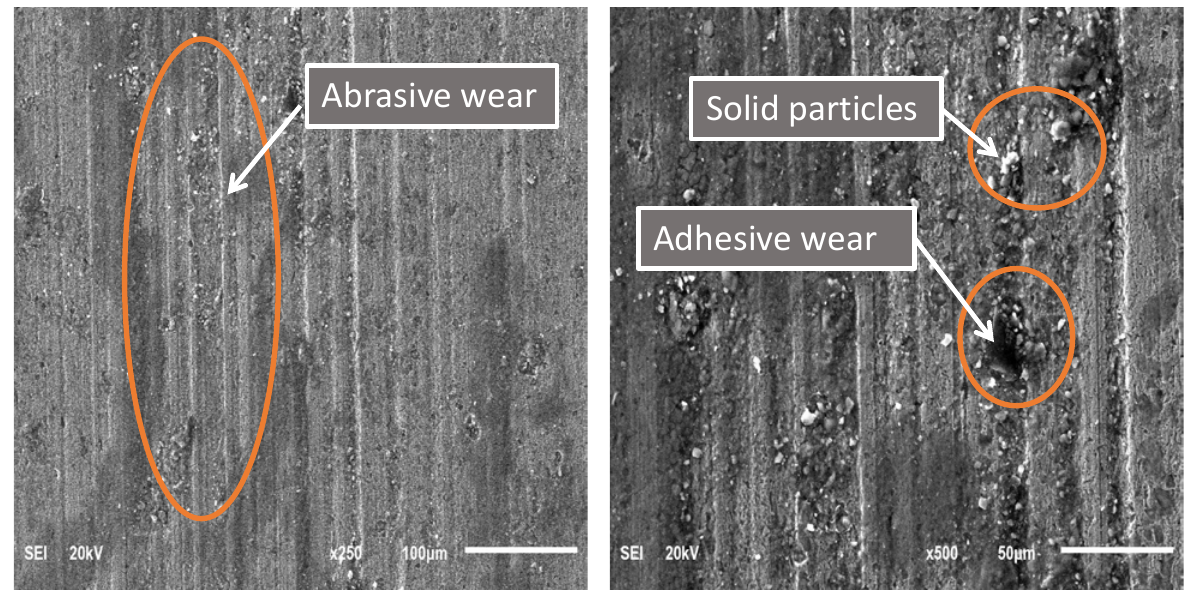
Figure 7. SEM images of the P110 worn casing sample (S0) tested under dry conditions at 115 rpm and 1000 N for 40 min.